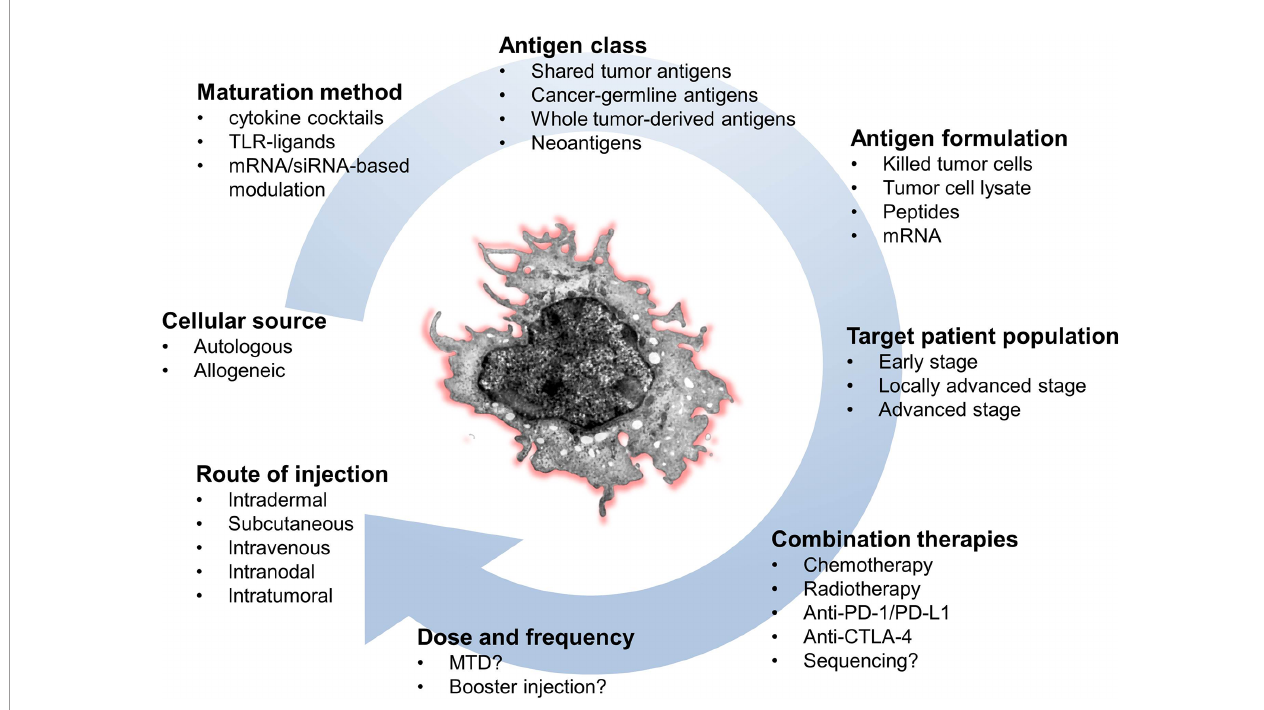
FIGURE 2 | Key parameters to optimize the success of DC-based immunotherapy. CTLA-4, cytotoxic T lymphocyte-associated antigen 4; DC, dendritic cell; MTD, maximum tolerated dose; PD-1, programmed cell death protein 1; PD-L1, programmed death-ligand